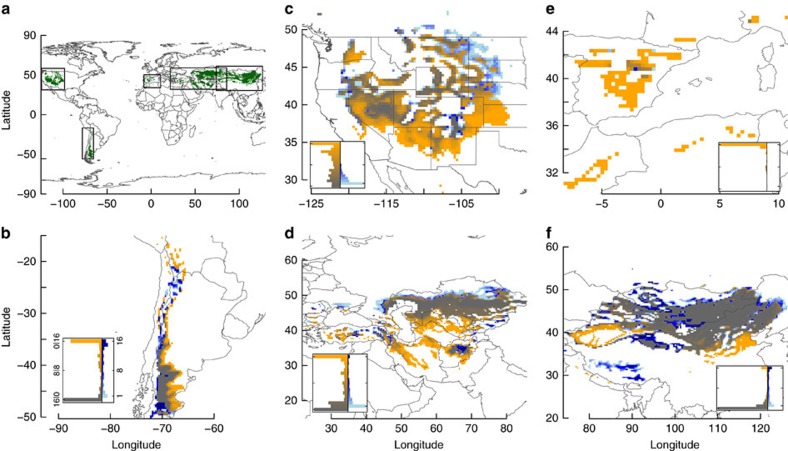
Current and future distribution of temperate drylands.(a) Five temperate dryland regions with their current extent for 1980–2010 (green): (b) South America; (c) North America; (d) Western and Central Asia; (e) Mediterranean Basin; (f) Eastern Asia. (b–f) Future projected change in extent under RCP8.5 for 2070–2100, depicted as stable (grey), contracting (orange; no longer temperate dryland in 2070–2100), and expanding (blue; newly temperate dryland in 2070–2100) zones. Inset vertical histograms for b–f illustrate areal abundance in each category of GCM agreement about expansion or contraction of temperate drylands. Left (grey-orange) histogram depicts GCM agreement (that is, number of GCMs that agree in the direction of change) about the fate of current temperate drylands and shows the number of cells within each category ranging from pure grey (all 16 GCMs forecast stable temperate drylands) to pure orange (all GCMs forecast conversion from temperate dryland to non-temperate and/or non-dryland). Right (light blue—dark blue) histogram indicates GCM agreement of temperate dryland expansion into new areas and shows the number of cells within each category ranging from dark blue (all GCMs forecast conversion to temperate dryland) to light blue (one GCM forecasts conversion).